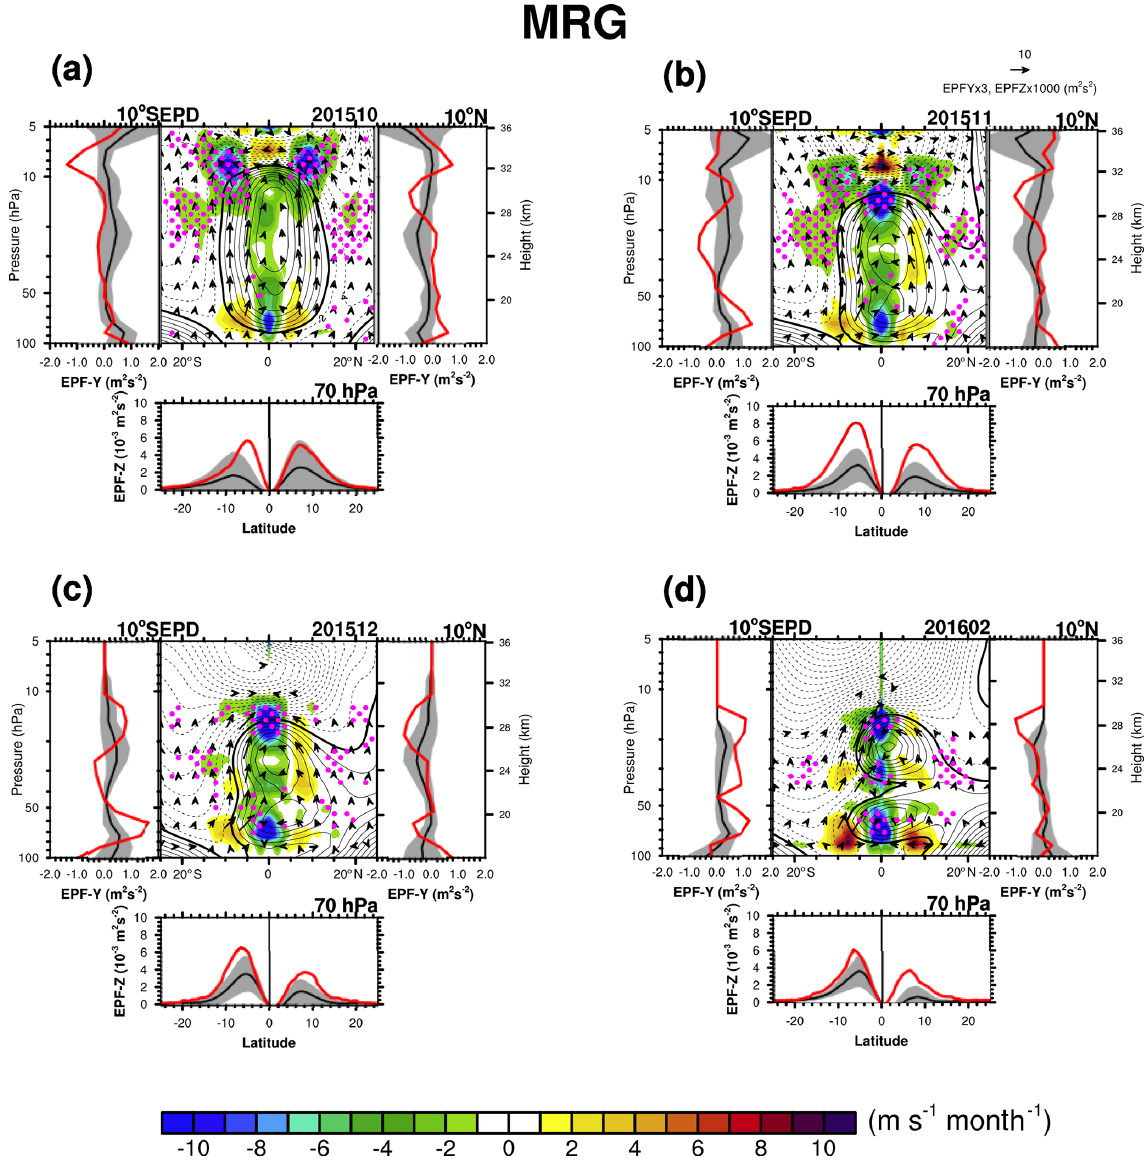
Figure 7. Latitude–height cross sections of the EP flux (vectors) and EP flux divergence (EPD, shading) for the MRG waves in (a) Oc- tober 2015, (b) November 2015, (c) December 2015, and (d) February 2016. The panel on the left (right) side of the EPD represents the meridional EP fluxes at 10 ◦ S (10 ◦ N), and the panel under the EPD represents the vertical EP flux at 70hPa (red lines for each month and black lines for their monthly climatology with ± 1SD; gray shading). Positive (negative) zonal winds are plotted with solid (dashed) lines with a contour interval of 2ms − 1 , and thick contour lines denote a zero zonal wind speed. The magenta stippled pattern represents a region where the EPD is algebraically smaller (more negative) than the climatology by more than its SD. Here, EPF and EPD are multiplied by 8 and 4,